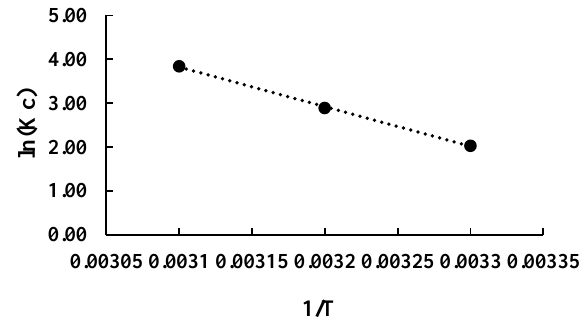
Fig. 6. Van’t Hoff plotting in thermodynamic study